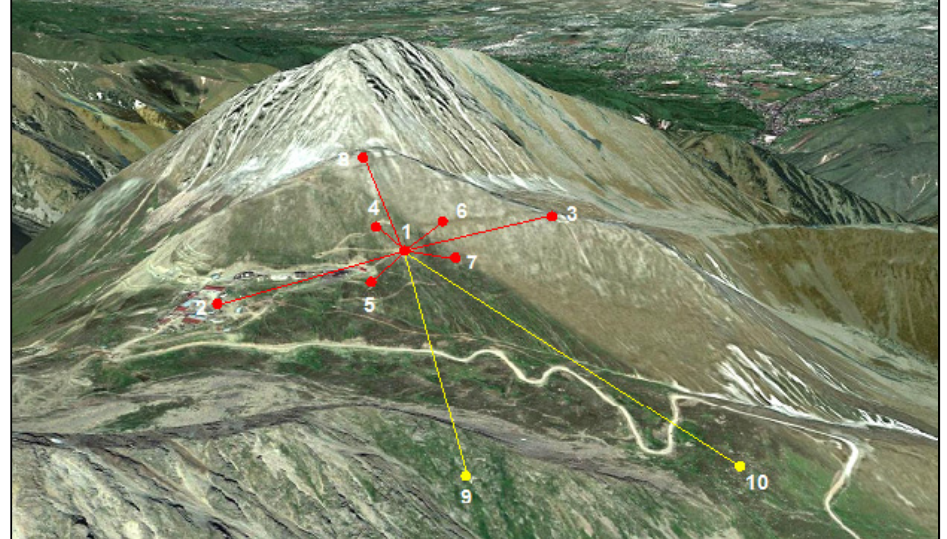
Figure 1. Disposition of the HORIZON-T detector points over the mountain pass of the Tien Shan station: an aerial view and a graph scheme. As an active medium for the detectors of the installation (1 × 1) m 2 sized polystyrene scintillator plates are used. The thickness of the plates is 10 cm in the points No (1–5), and 5 cm in the points No (6–12) (refer to Figure 1). Besides the scintillator, there is an additional Cherenkov detector in the point No